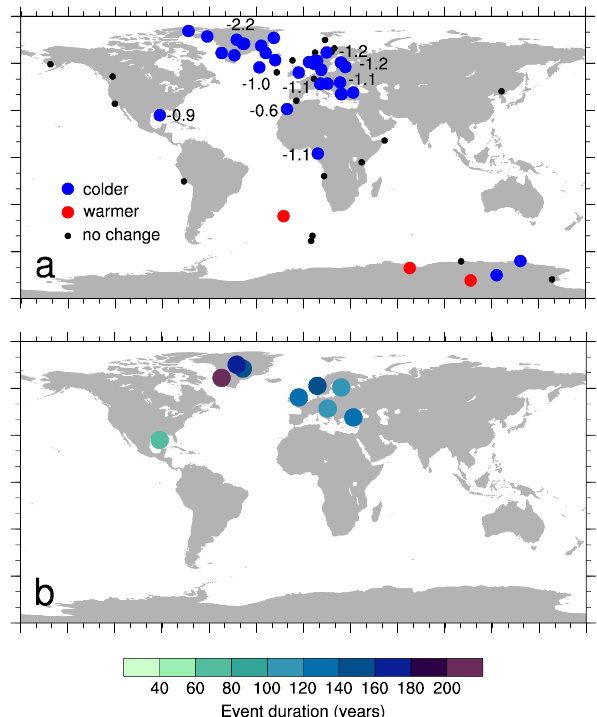
Figure 3. (a) Temperature anomalies relative to early Holocene background climate (defined 4 Fig. 3. (a) Temperature anomalies relative to early Holocene back- as the average between 7.4-7.9 and 8.5-9.0 calendar ka) detected near 8.2 ka by the method 5 ground climate (defined as the average between 7.4–7.9 and 8.5–9.0 calendar ka) detected near 8.2ka by the method described in text. described in text. Black dots indicate sites with temperature proxies that did not have an 6 Black dots indicate sites with temperature proxies that did not have identifiable anomaly. Values plotted are quantitative mean annual temperature estimates in 7 an identifiable anomaly. Values plotted are quantitative mean an- degrees Celsius and are also provided in Table 1. (b) Duration of temperature anomalies in 8 nual temperature estimates in degrees Celsius and are also provided high-resolution (better than 15 yrs/sample) proxies, as determined using the method of 9 in Table 1. (b) Duration of temperature anomalies in high-resolution Wiersma et al. (2011). 10 (better than 15yr/sample) proxies, as determined using the method of Wiersma et al.